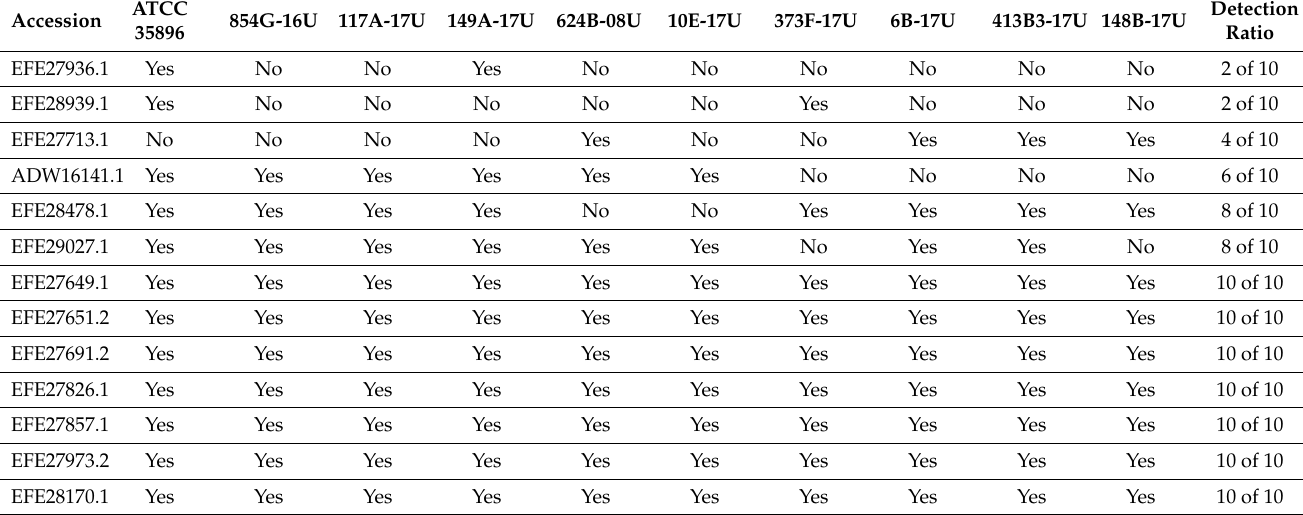
Table 1. Detection of the EV proteins in the ten F. alocis strains. All EV proteins detected by label free in each of the ten strains, respectively, are